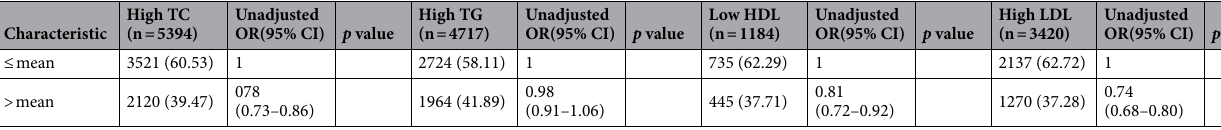
Table 2. Association between serum high TC, high TG, low HDL and high LDL with selected variables in study